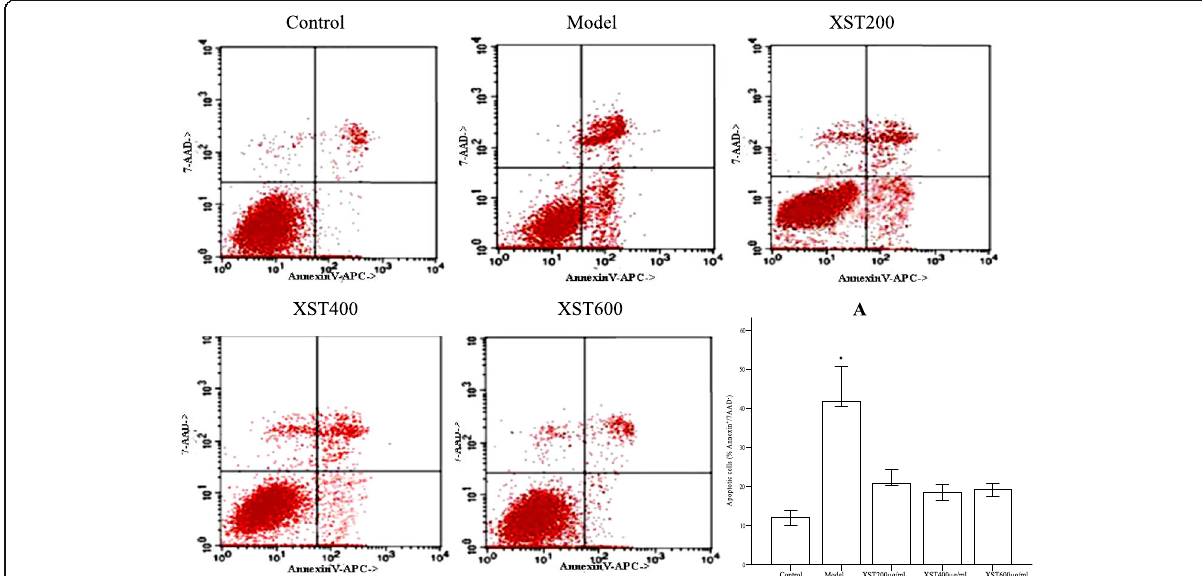
Fig. 8 Five groups were subjected to an assessment of apoptosis cells in the typical diagrams by flow cytometry (annexinV + /7-AAD − ). The percentage of annexinV + /7-AAD − , as the index of the apoptosis cells, increased in the model group. XST-treated groups declined the apoptosis cells as indicated by the quantitative bar graph ( a ). All samples were tested in three independent experiments with three replicates each. Data are represented as the mean ± SD ( * P < 0.05 vs. the control or the XST-treated